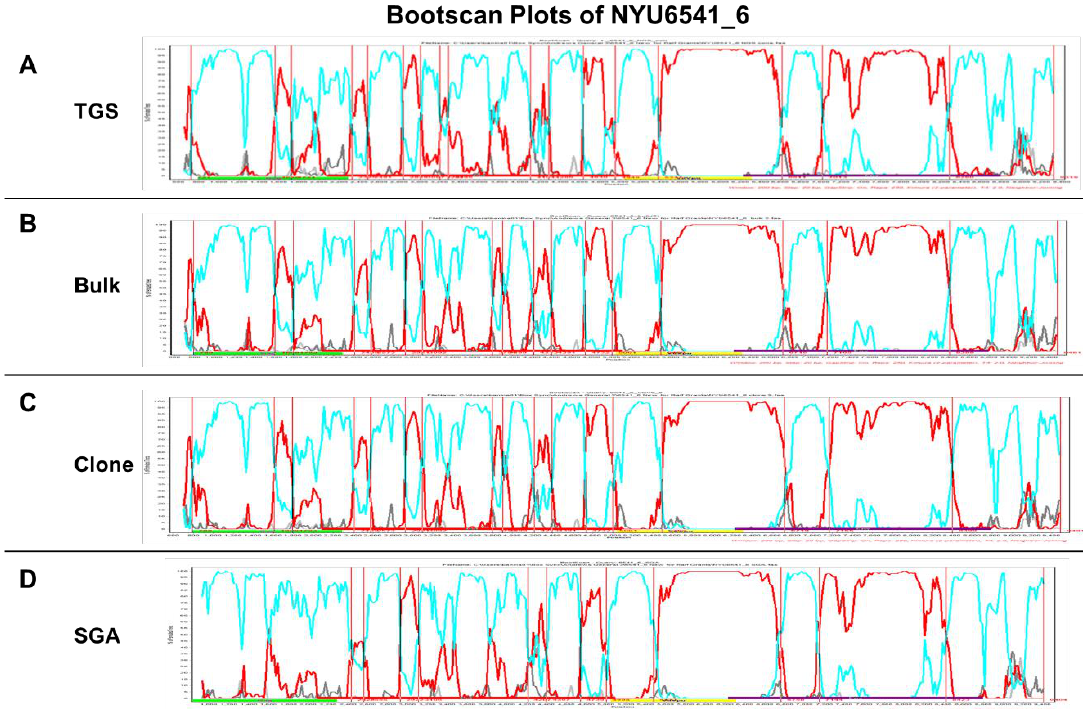
Figure 5. Comparative recombinant breakpoint analysis of near full genome sequences obtained with four different amplification, sequencing, and cloning strategies. Using sample NYU6541_6, different amplification, sequencing, and cloning techniques were studied: ( A ) third-generation sequencing (TGS), ( B ) bulk amplification and Sanger sequencing, ( C ) cloning after bulk amplification, followed by Sanger sequencing, and ( D ) single genome amplification (SGA) and Sanger sequencing. BootScan plots (Simplot software) are shown for near full genome sequences of NYU6541_6 with window size 200 and step size 20. Breakpoint patterns were determined by analyzing the query sequence against CRF02_AG (red), F2 (cyan), C (dark gray), and B (light gray) reference strains. The genomic regions gag , pol , vif/vpr/vpu and env are schematically shown along the x-axis in green, red, yellow, and purple bars, respectively. The y -axis indicates bootstrap values obtained after 250 replicative measurements.